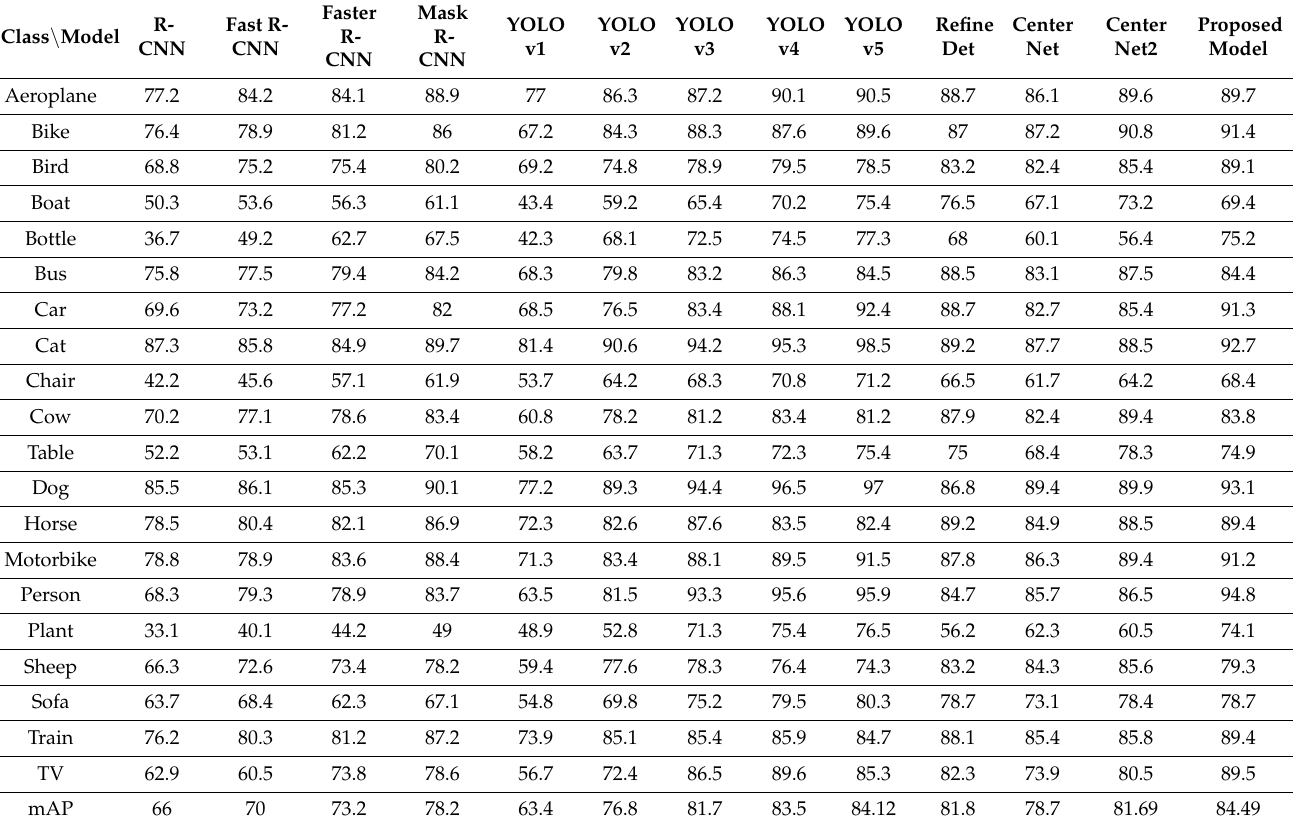
Table 6. Class-wise performance of the existing models with the proposed model using PASCAL VOC 2007 dataset.